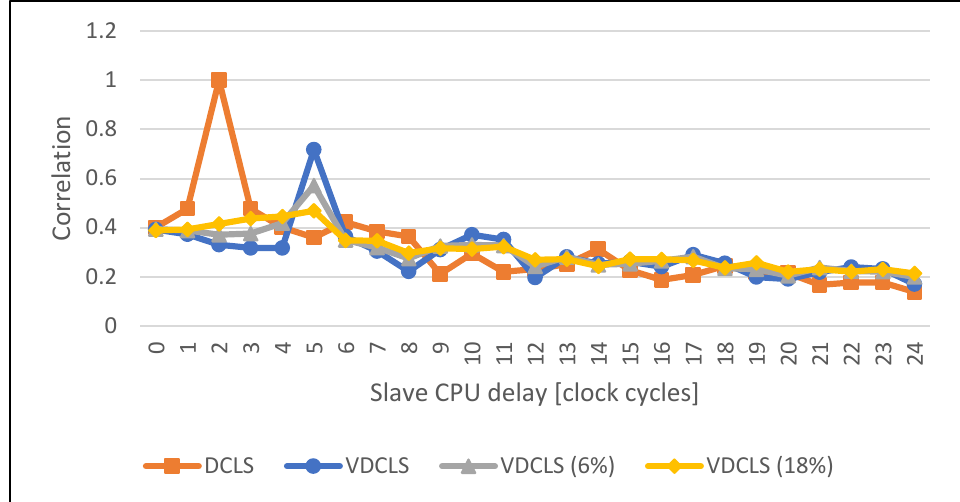
Figure 18. Comparison of the execution correlation between master and slave CPUs using VDCLS with dummy cycles insertion and legacy DCLS technique while executing the SHA algorithm.